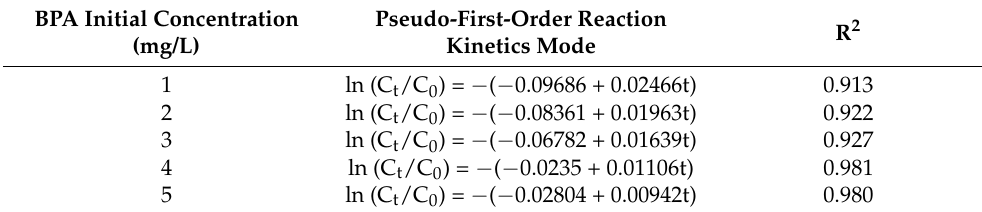
Table 3. The kinetic parameters of BPA